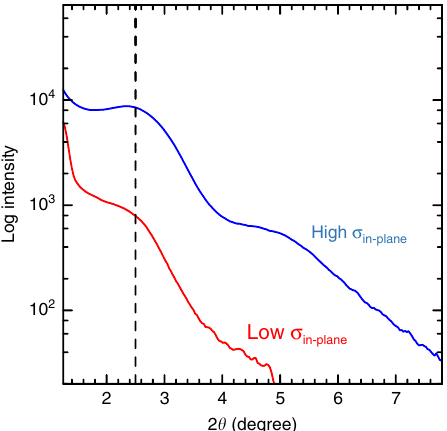
Fig. 5 X-ray diffraction structural analysis of quantum dot multilayers. Out-of-plane X-ray diffraction patterns of CdTe quantum dot 30 layers with low (red) and high (blue) in-plane quantum dot density ( σ in-plane ). The dashed lines show the peak value of the X-ray